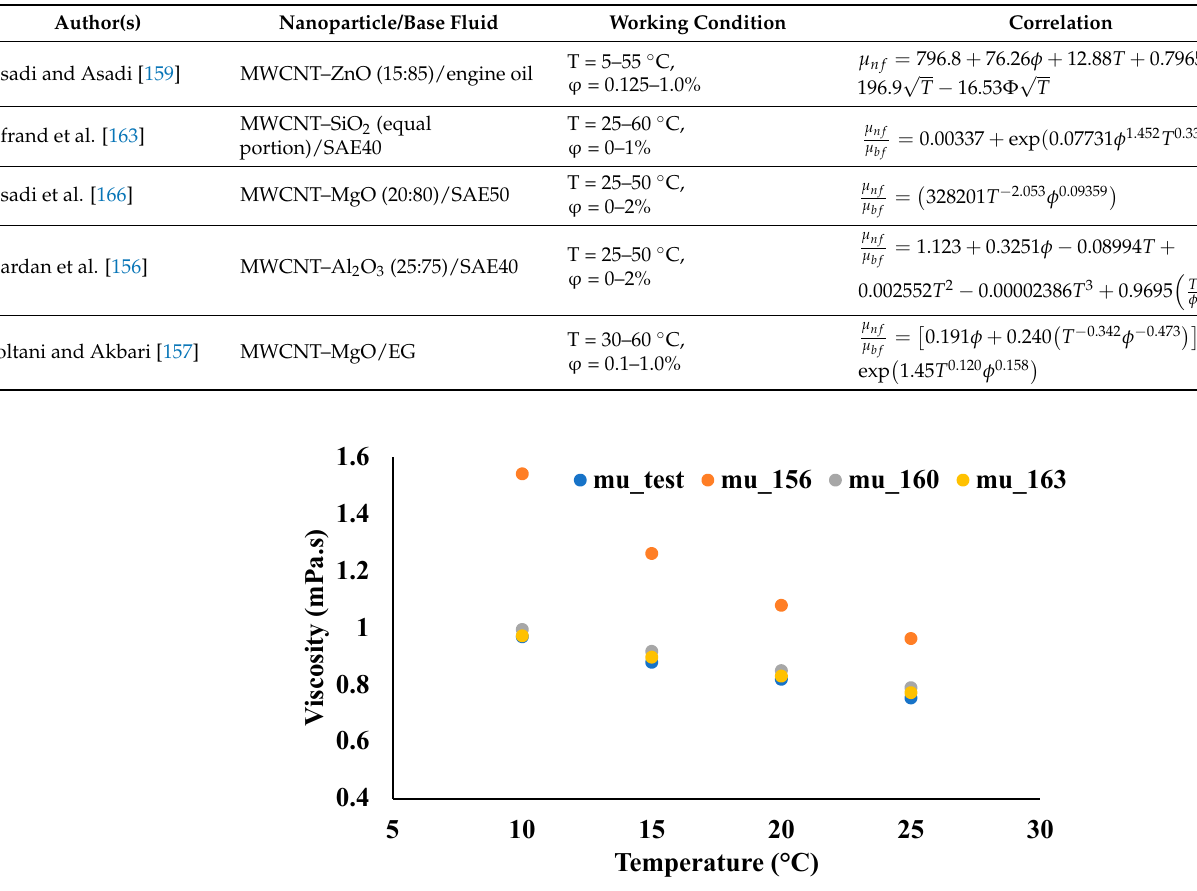
Figure 5. Comparison of experimental and empirical results for viscosity.